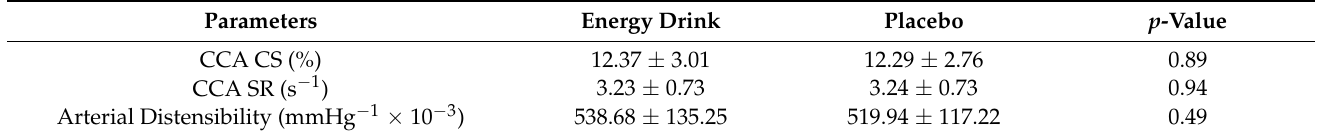
Table 2. Parameters of Arterial Stiffness at Baseline ( n = 27).